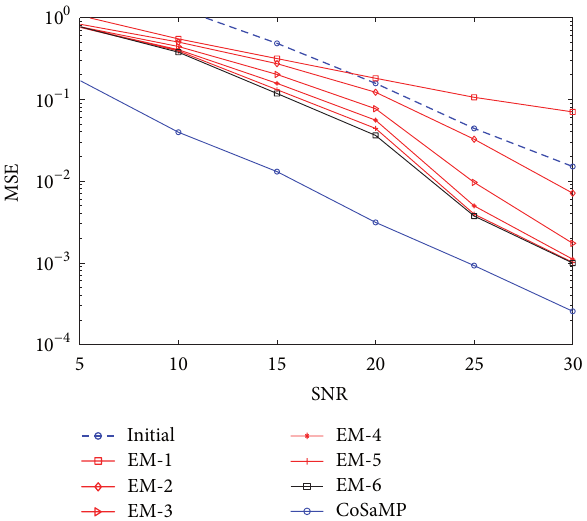
Figure 2: MSE performance of channel estimation at T 1 for the case when 𝑑 = 2 .